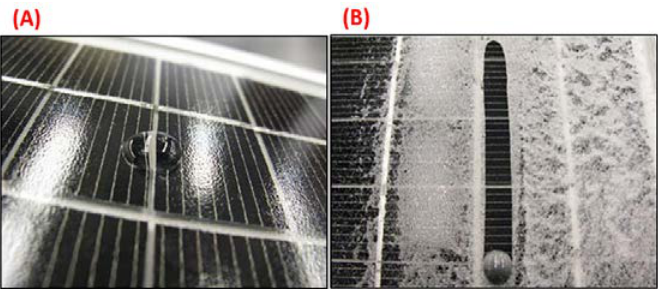
Figure 3. Self-cleaning hydrophobic coatings; ( A ) nanomaterial coated solar PV panel, and ( B ) water rolls off the surface like a sphere rolling down a slide.